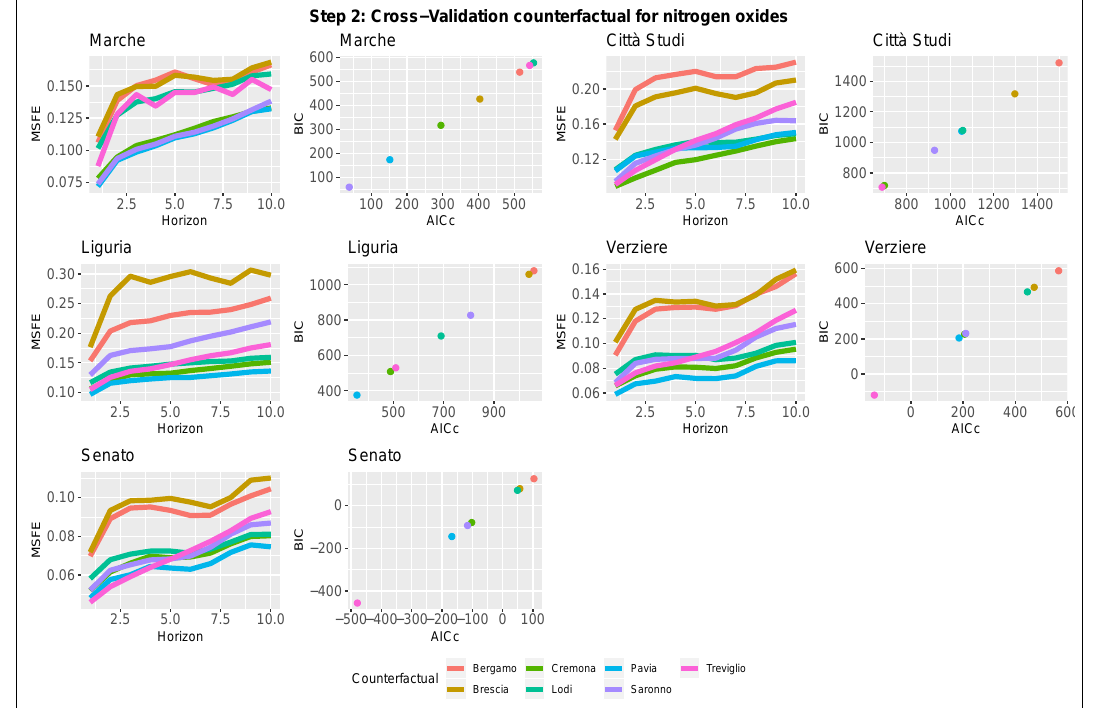
Figure 7. Model selection-Step 2-NO x . Counter-factual term selection for the five nitrogen oxides stations in Milan. Left panel: 10-steps-ahead MSFE in log-scale as function of the candidate. Right panel: AICc and BIC pairs for each model.